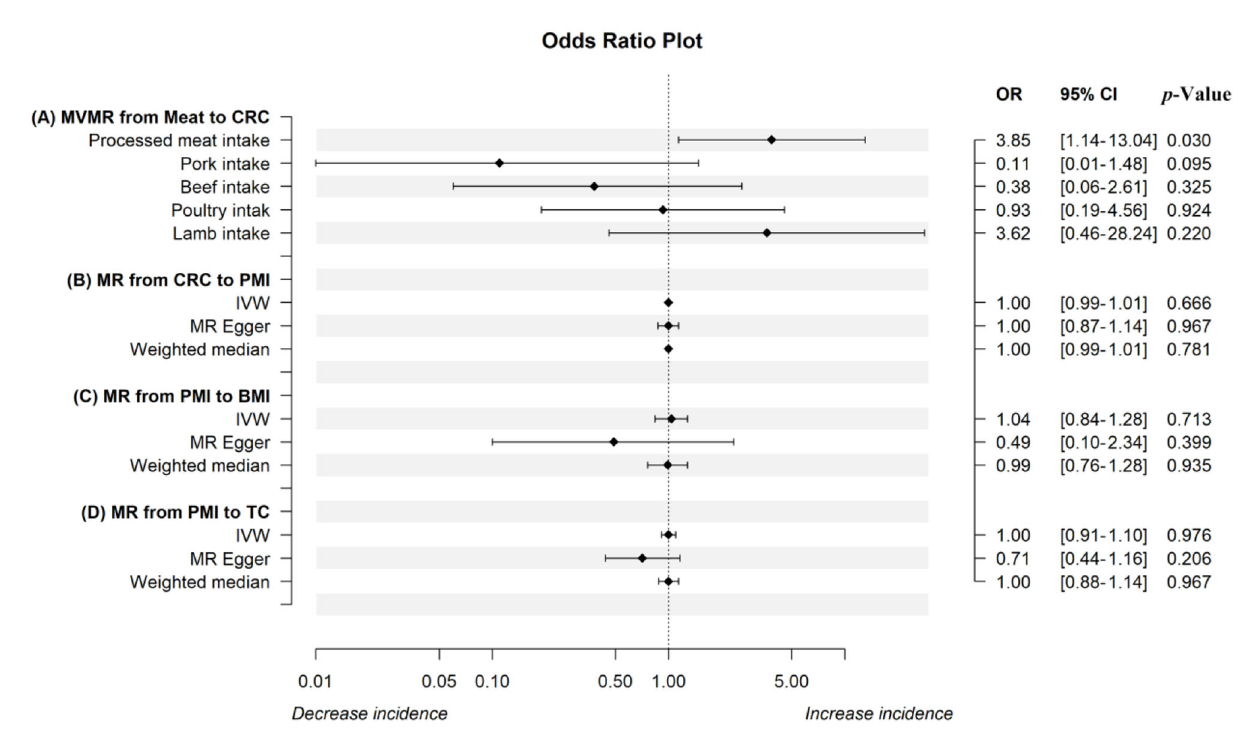
FIGURE2 The odds ratio plot of the MR analysis. The odds ratio plot (A) shows estimates of the MVMR analysis from meat intake on CRC in IVW methods when controlling for the other four factors, respectively. The results from IVW, the MR-Egger method, and the weighted median in the univariable MR analysis from CRC to PMI, PMI to BMI, and PMI to TC were displayed in odds ratio plots (B–D). MR, mendelian randomization; MVMR, multivariable Mendelian randomization; IVW, inverse-variance weighted; CRC, colorectal cancer; PMI, processed meat intake; BMI, body mass index; TC, total cholesterol.